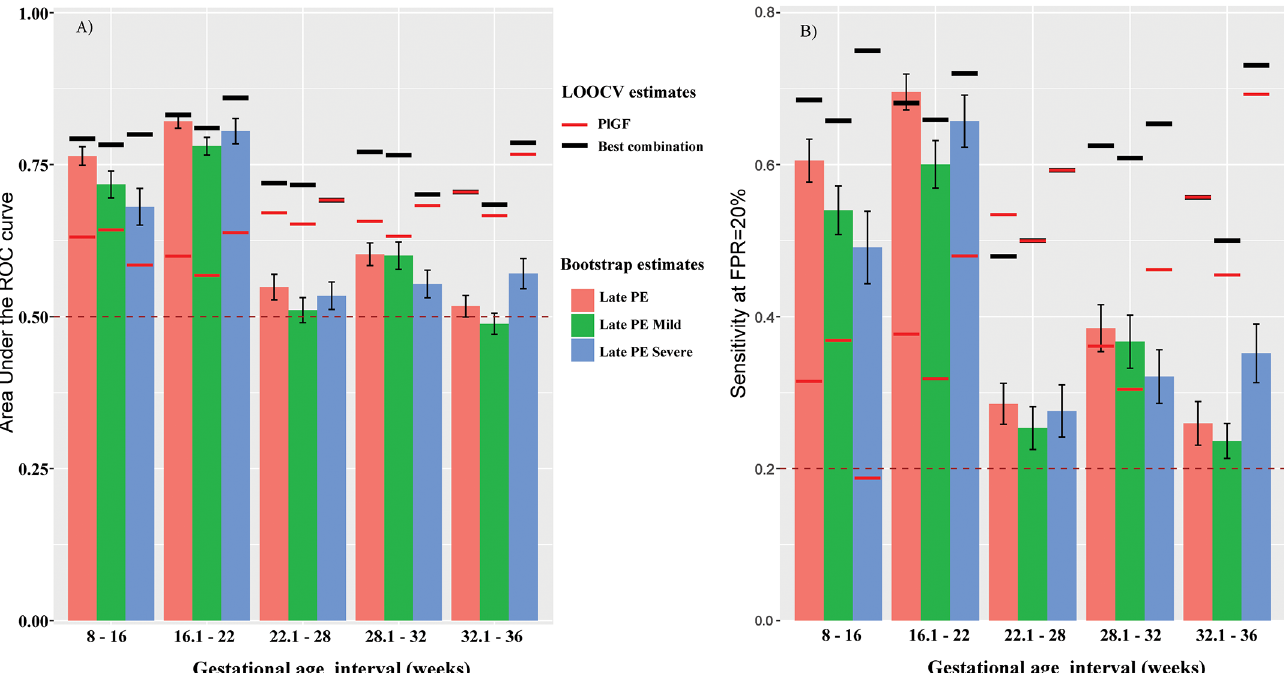
Fig 1. Prediction of late-onset preeclampsia using multi-protein markers. The area under the Receiver OperatingCharacteristic (ROC) curve (A) and the sensitivity at a 20% false positive rate (FPR) (B) are shown. Estimates obtainedby leave-one-out cross-validation (LOOCV) for the best combination of markers (Table 2) is shown as horizontal black segments for late preeclampsia (PE) as well as for mild and severe phenotypes of the disease.The LOOCV performance of PlGF alone is shown with red horizontalsegments. The bars in this figure represent average(whiskers are with 95% confidenceintervals[CI]) prediction performance obtainedfrom 100 bootstrapiterations. For predictionof severe preeclampsia at 28.1–32weeks and for overall preeclampsia at 32.1–36weeks, PlGF was the only predictor selectedin the final